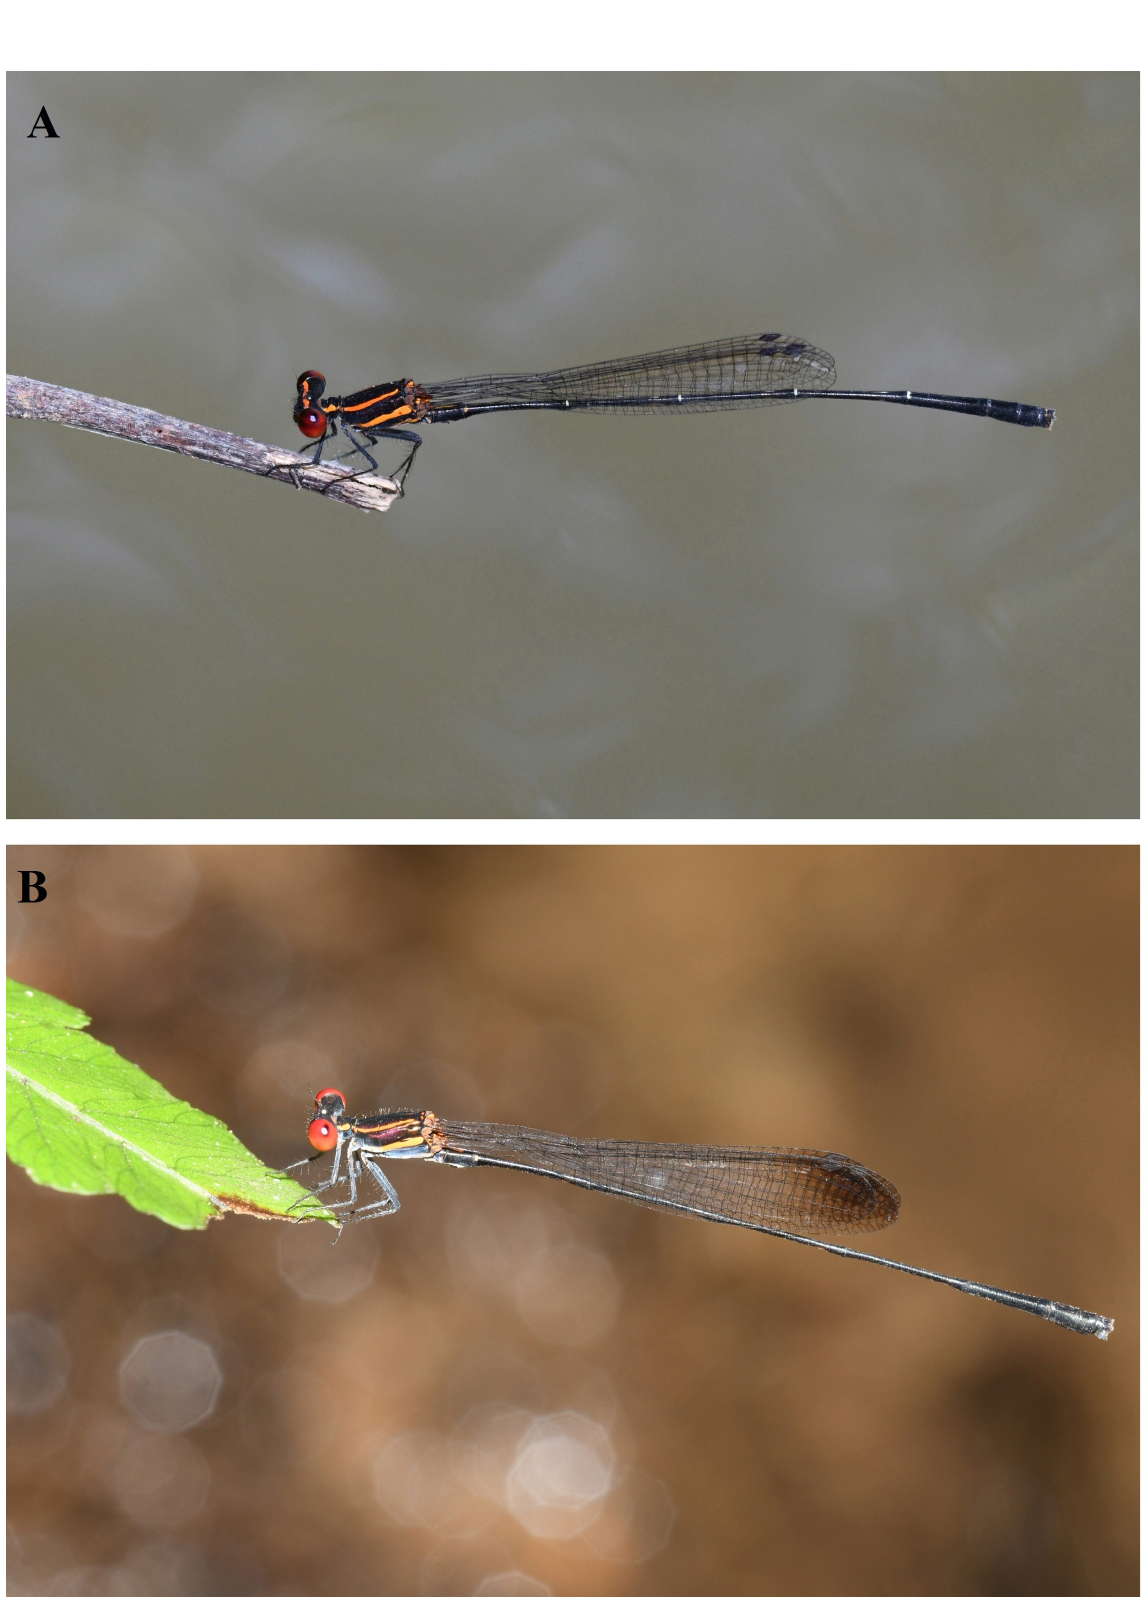
Fig. 15. Prodasineura Cowley, 1934 spp., males, in nature. A . P. kong sp. nov. B . P. lancastrei sp.